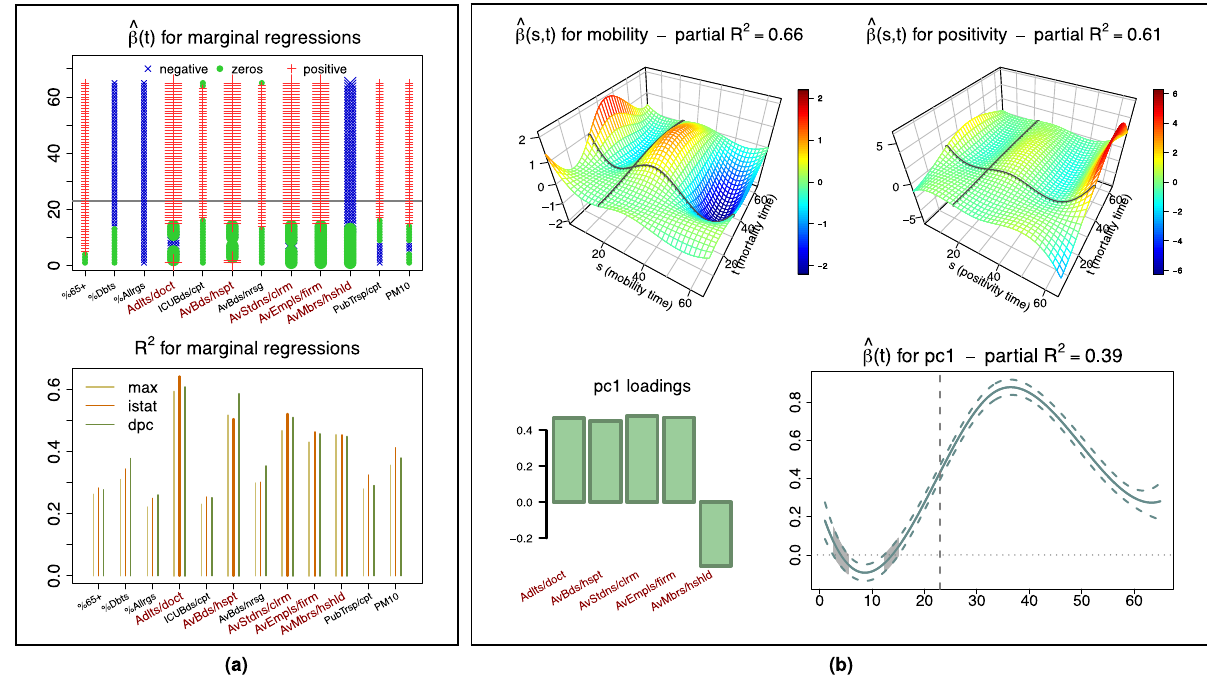
Figure 6. Associating mortality to socio-demographic, infrastructural and environmental factors. (a) Results from marginal function-on-scalar regressions. Mortality curves are regressed against each of the scalar covariates in Table 1. The top plot displays the signs of the effect curves estimated on the MAX data. Time, marked as the 65 days of the region specific epidemic unfoldings, is on the vertical axis (the nationwide lock down on March 9, without shift, is marked by a horizontal line. Red, blue and green indicate, respectively, positive, negative and non-significant portions (i.e., where 95% confidence bands around the estimated effect curve are entirely above, entirely below, or contain 0; see Methods). The bottom plot displays in-sample R 2 s for the regressions fitted on MAX, ISTAT and DPC data; these are remarkably consistent. The names in red on the horizontal axes indicate the top 5 covariates selected by SnNAL-EN on all three data sets (see Methods); these are also the ones with the largest R 2 s. ( b ) Results from the joint function-on-function regression of MAX mortality on local mobility, positivity, and the first principal component (pc1) of the top 5 covariates, used as a “summary” control. This control does not modify the shapes of the estimated effect surfaces for mobility and positivity (shown on top)—which are very similar to the ones in Fig. 4(b). The estimated effect curve for pc1 shows a positive and significant association with mortality at its peak (bottom right; 95% confidence band in dashes, gray corresponds to non significant portions, vertical dashed line corresponds to March 9, without shift). The sign of this effect is consistent with marginal findings, based on the loadings of the first principal component (bottom left; positive for adults per family doctor, average beds per hospital, average students per classroom and average employees per firm, and negative for average members per household). With the addition of pc1, the regression reaches an in-sample R 2 = 0.94 and a LOO-CV R 2 = 0.7 . The contributions of local mobility and positivity remain high (partial R 2 = 0.66 and 0.61, respectively). That of our “summary” covariate is also substantial (partial R 2 = 0.39